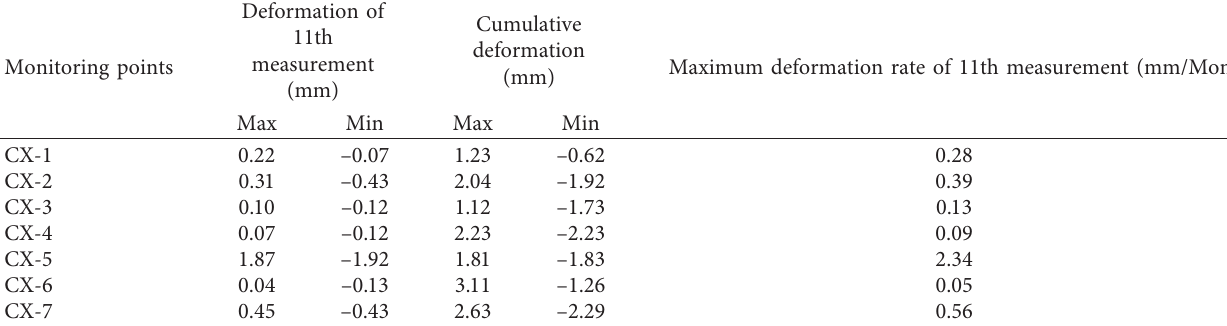
Table 6: Data analysis of internal deformation of